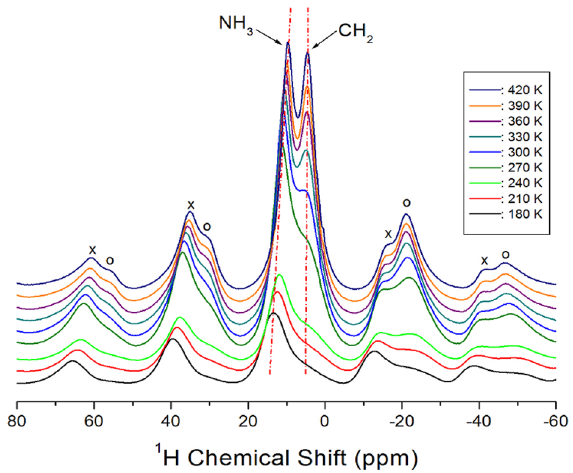
Figure 3. 1 H NMR chemical shifts for NH 3 and CH 2 in [NH 3 (CH 2 ) 3 NH 3 ]CuBr 4 at several temperatures.